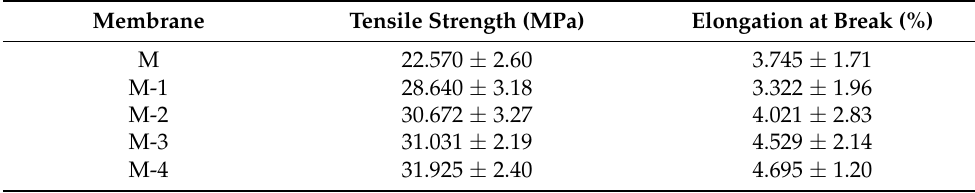
Table 1. Mechanical properties of the Ge-incorporated NaCMC membranes.